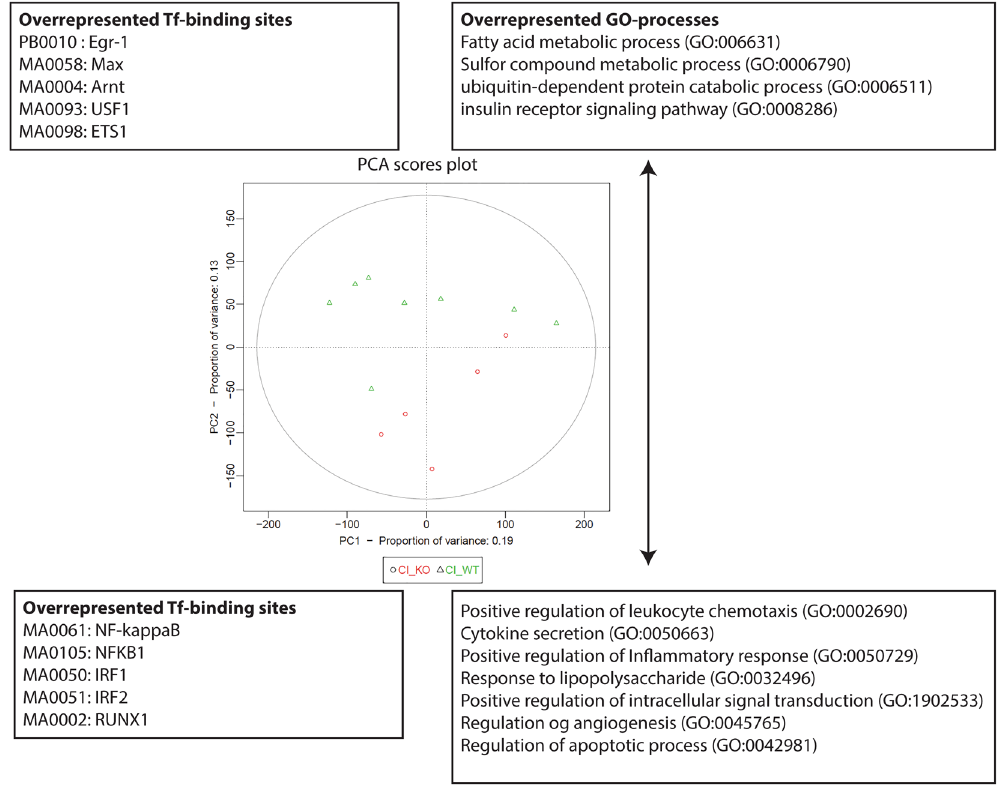
Figure 4. PCA score plot of inflamed colon tissue samples. RNA was extracted from chronically inflamed colons (7 weeks, second DSS cycle) of Cygb − / − mice (chronic inflammation knockout: CI_KO, red circles, n = 5) and from WT mice (chronic inflammation wild type: CI_WT, green triangles, n = 8) and subjected to a microarray analysis (Affymetrix Mouse Gene 2.0 ST array). An unsupervised multivariate analysis followed by GO and promoter overrepresentation analyses were conducted using the pcaGoPromoter package. The score plot of the first two PCs are shown. The variation represented by the second PC (the Y-axis) is correlated with the Cygb genotype. The most important GO terms associated with each direction of the second PC axis are shown together with the most important overrepresented predicted transcription factor binding sites in the promoters of the genes defining either direction of the second PC axis. The results suggest that more-severe inflammation was present in Cygb − / − mice than in WT